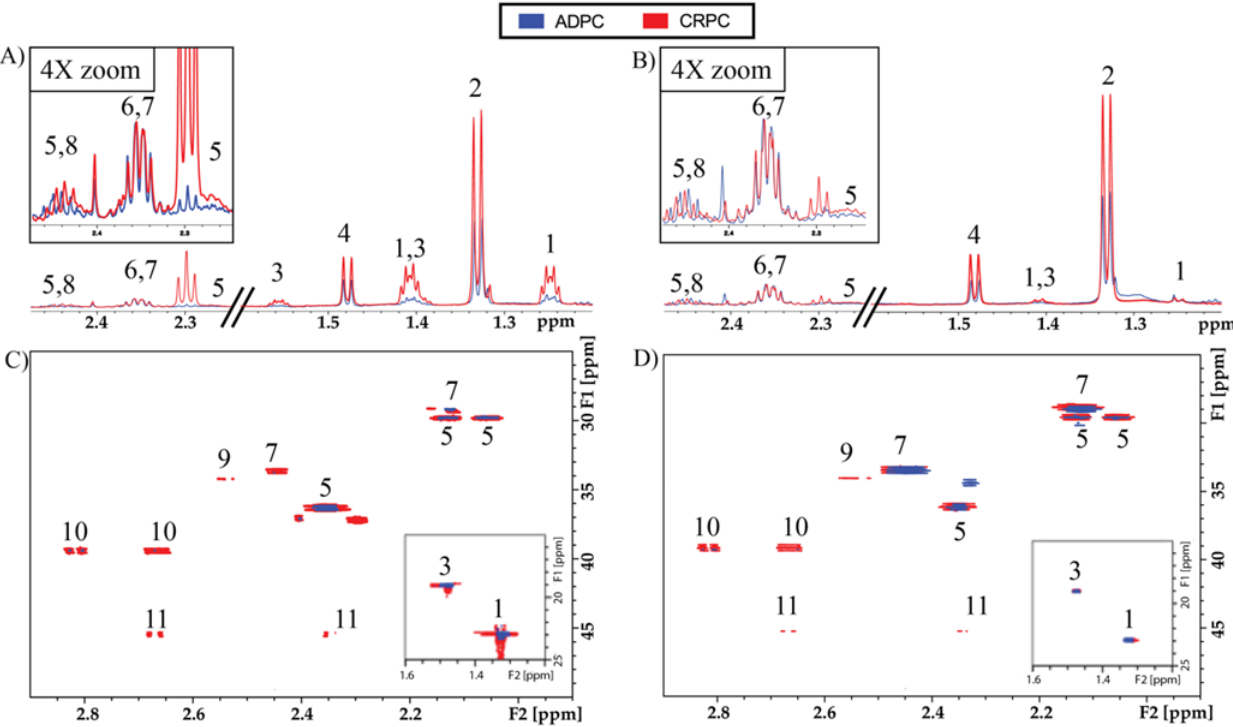
Figure 1. High-resolution NMR spectra of tumor extracts. Representative 1D 1 H spectra with water presaturation of ADPC (blue) and CRPC (red) TRAMP tumors labeled with ( A ) [U- 13 C]glucose, and ( B ) [U- 13 C]glutamine. Zoomed region indicates glutamate C4 region with vertical scale increased by 4-fold. High resolution 2D 1 H- 13 C HSQC of ADPC and CRPC TRAMP tumors labeled with ( C ) [U- 13 C]glucose, and ( D ) [U- 13 C]glutamine. Metabolite peaks are labeled as follows: (1) 13 C-Lactate, (2) Lactate, (3) 13 C-Alanine, (4) Alanine, (5) 13 C-Glutamate, (6) Glutamate, (7) 13 C-Glutamine, (8) Glutamine, (9) 13 C-Glutathione, (10) 13 C-Aspartate, (11) 13 C-Malate.